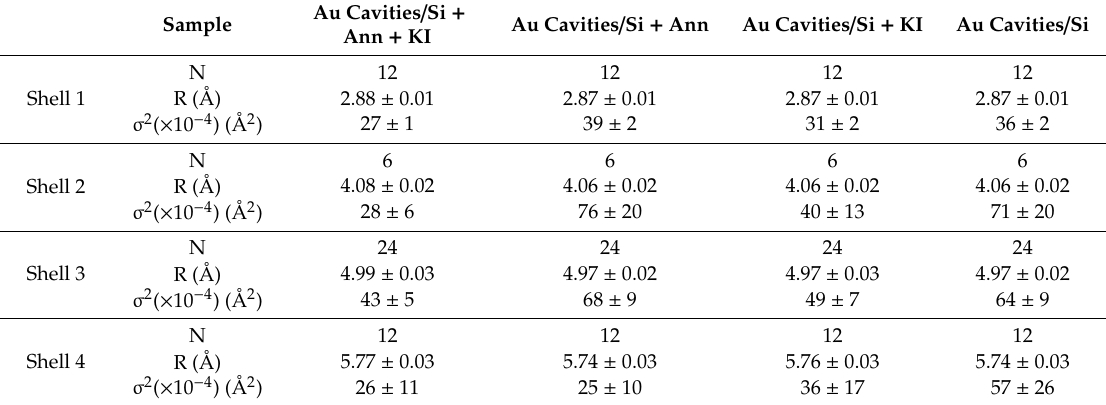
Table 1. Results from the EXAFS fittings of the di ff erent Au cavities (N represents the coordination number, R the distance to the absorbing atom, and σ 2 is the shell mean-square disorder). All shells correspond to Au-Au single scattering events.